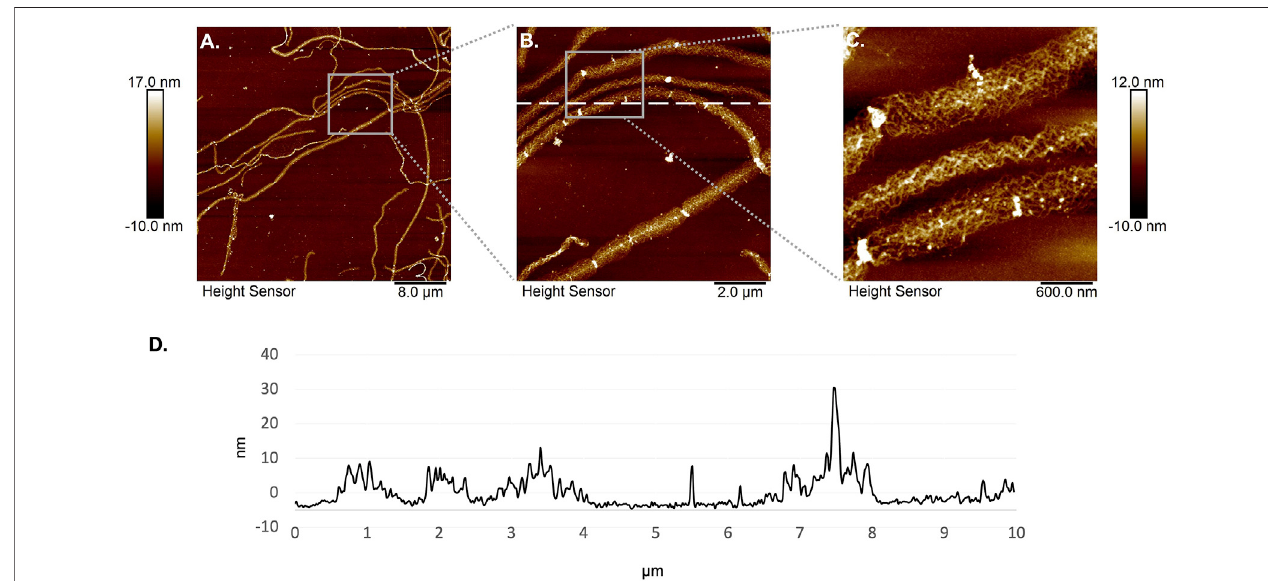
FIGURE 4 | Atomic force microscopy observations of fi bers composing the WJ-ECMaa. (A – C) Height sensor acquisitions of fi bers present in the WJ-ECMaa coating. (D) Cross-section analysis of height sensor acquisition.